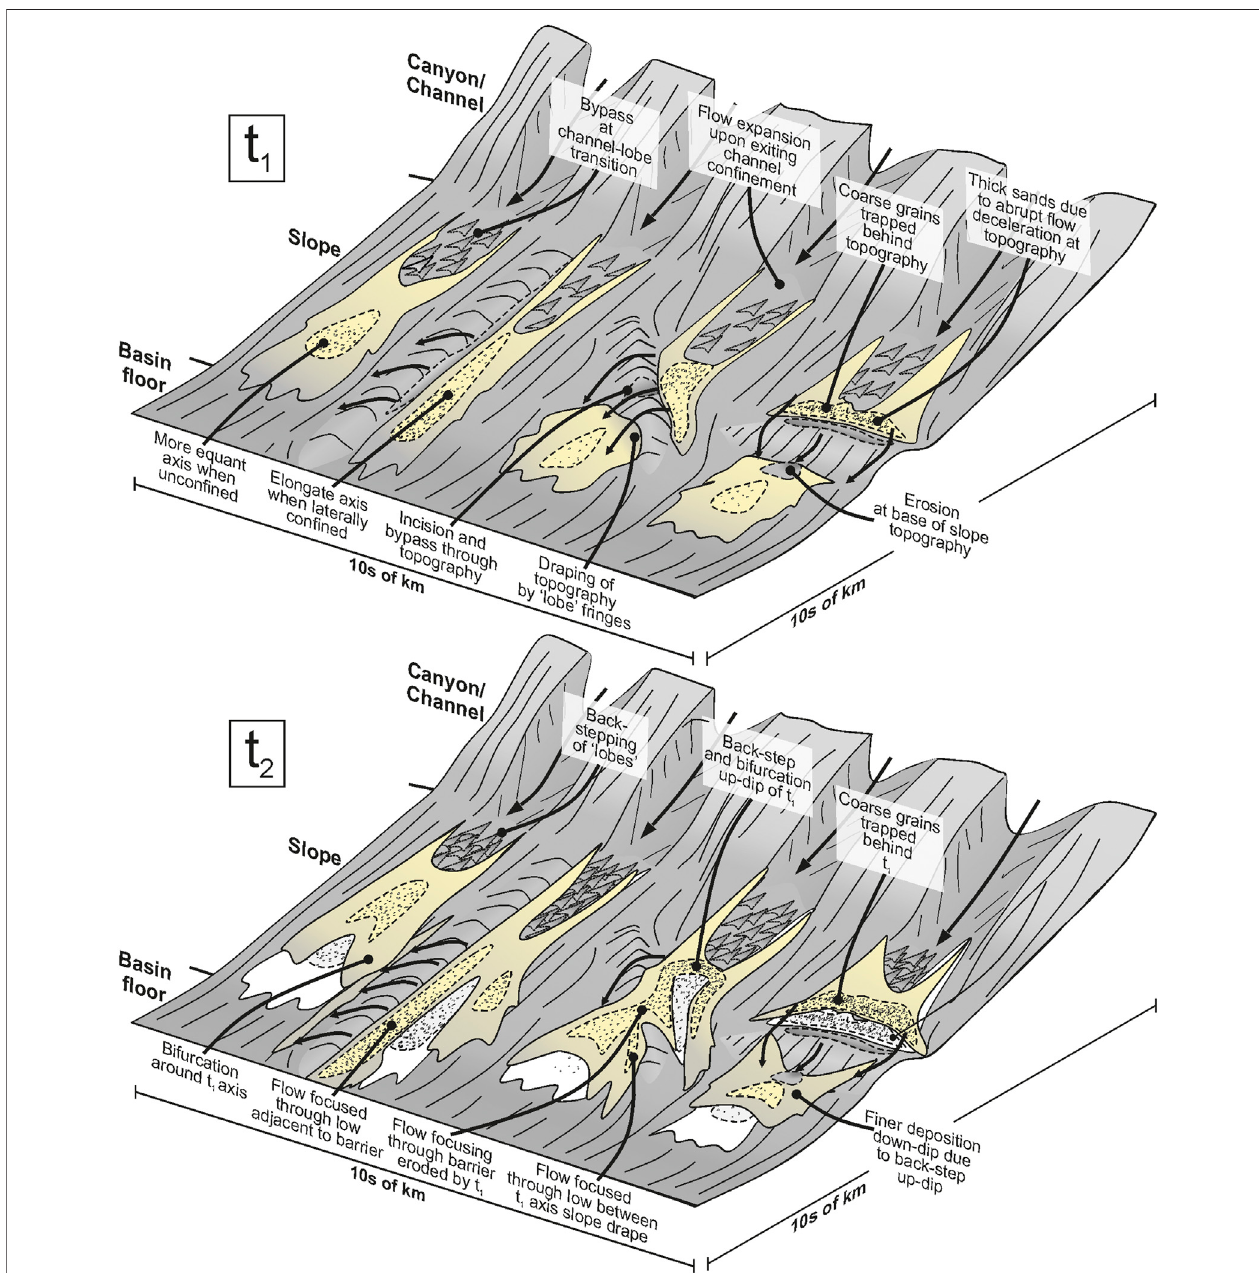
FIGURE 15 | Summary schematic diagram showing the depositional features and stacking patterns that can be expected on a topographically-complex slope based on these experiments. Initial deposition (t 1 ) is based on the experiments, while t 2 is hypothetical. Initial deposition (t 1 ) indicated by white fi ll on t 2 .